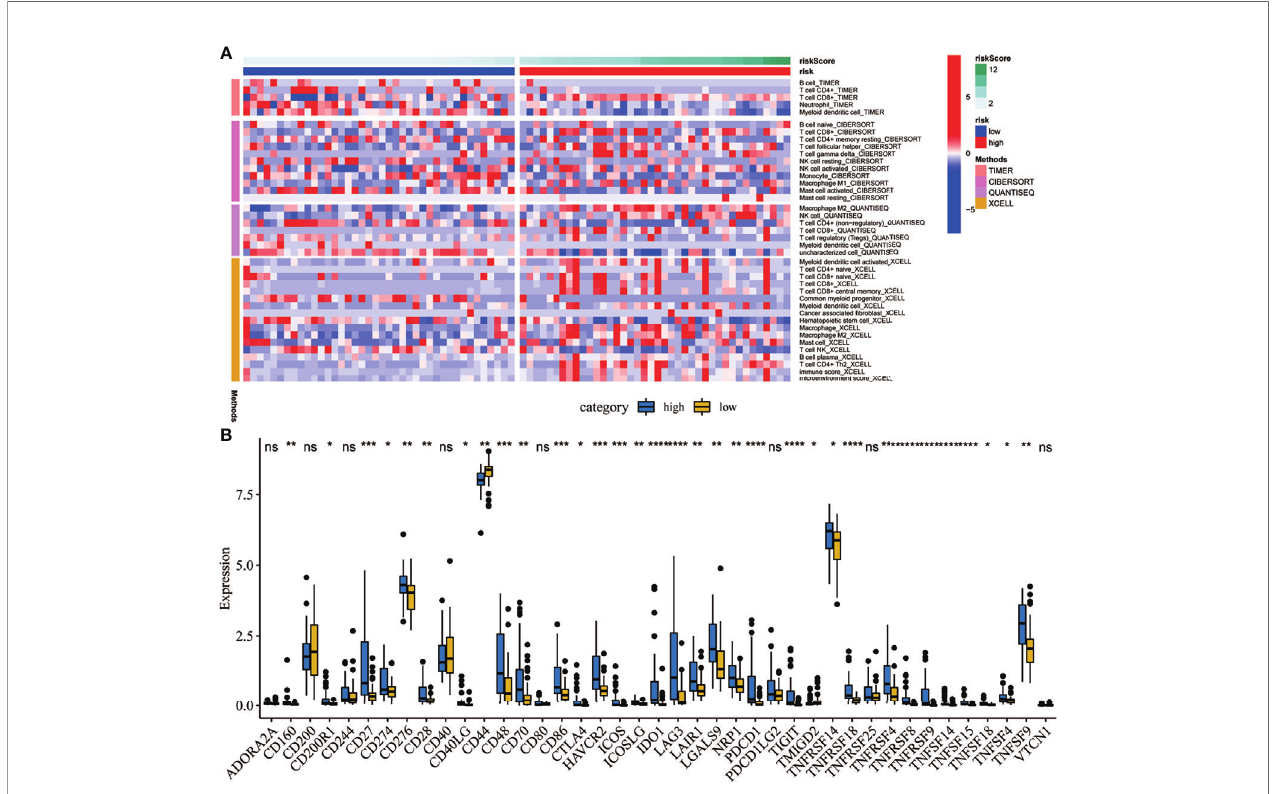
FIGURE 9 | Correlation analysis between the risk scores and the immune microenvironment. (A) Heat map showing the correlations between the risk scores and immune cell in fi ltration using four methods. (B) Correlation analysis between the risk scores and several immune checkpoint molecules. *P < 0.05. **P < 0.01. ***P < 0.001. ****P < 0.0001. ns, no signi fi